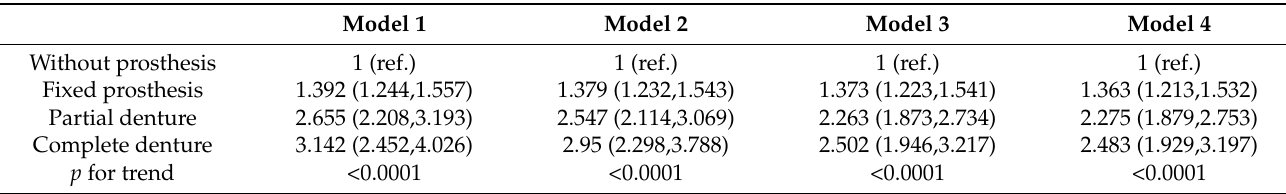
Table 3. Odds ratios of chewing discomfort in the participants with respect to the dental prosthesis type (95% confidence interval (CI)) .